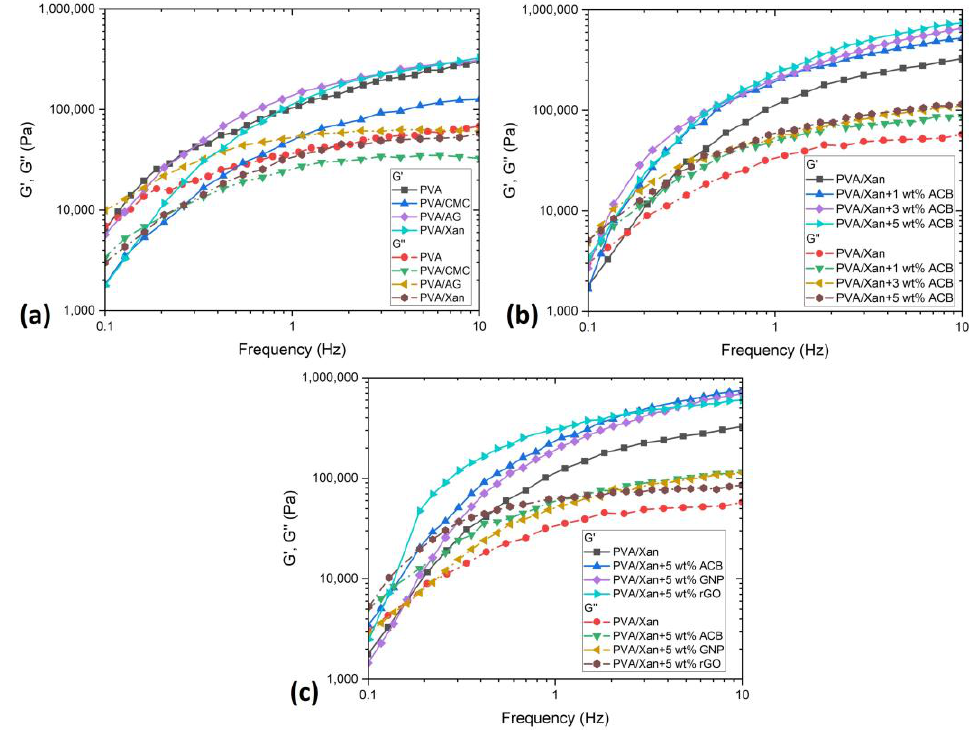
Figure 5. Viscoelastic properties of hydrogels with a dependence on the frequency sweep of hydrogels with ( a ) different polysaccharide modifiers, ( b ) different percentages of fillers, and ( c ) different fillers.